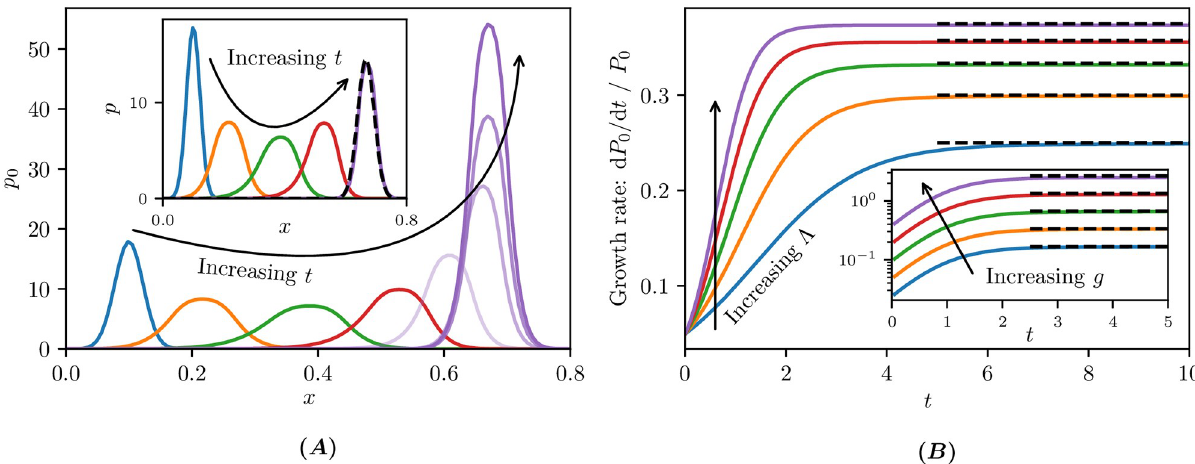
Fig 6. Chemical kinetics coupled to state-dependent growth. Simulations of (18) for G ( x ) = gx and the birth and death functions given in (20). Initial ffiffiffiffiffiffiffiffiffiffiffiffi p conditions are p ð x ; 0 Þ ¼ exp ð(cid:0) 10 3 ð x (cid:0) 0 : 1 Þ 2 Þ 10 3 = p and p 1 ( x , 0) = 0. (A) Density p 0 for growth factor g = 0.5 and birth factor Λ = 3 at times t 2 {0, 0 0.5, 1, 1.5, 2, 3, 4, 5}; (A inset) normalised density p = p 0 / P 0 with P 0 defined in (23) at times t 2 {0, 0.5, 1, 1.5, 5}. The black dashed curve shows the asymptotic approximation of the limiting profile given by (S46) in Section 3 in S1 Appendix. (B) Growth rate (d P 0 /d t )/ P 0 for growth factor g = 0.5 and birth factor Λ 2 {2, 2.5, 3, 3.5, 4}; (B inset) Λ = 3 and g 2 {0.25, 0.5, 1, 2, 4}. The black dashed lines show the large time predictions ((S47) and (S50)). The state space discretisation was Δ x = 0.007 (i.e. lumping 7 states together).